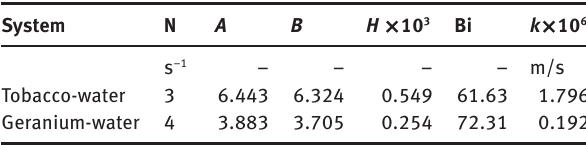
Table 3: Values of the constants A , B , H , Bi number, and the partial mass transfer coefficient k